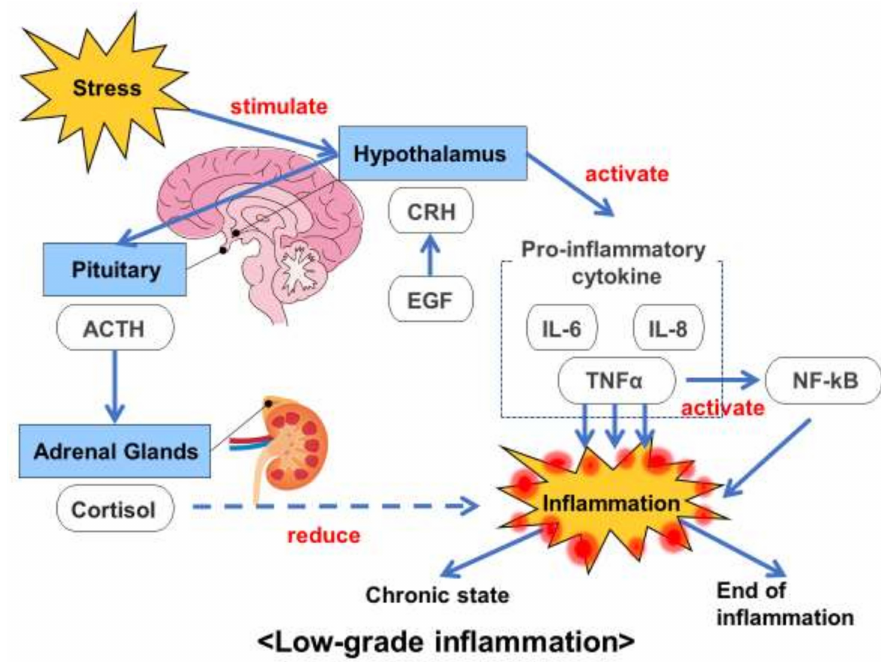
Figure 5. Association between biomarkers of low-grade inflammation and